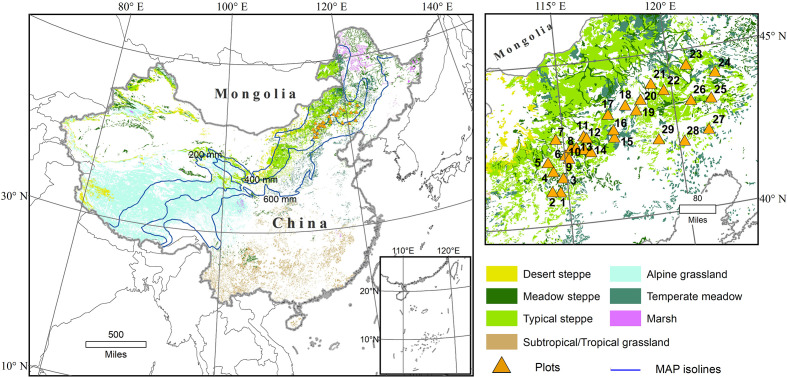
Distribution of grass types in China, with locations of the study region and sampling sites (orange triangles with numbers consistent with
Table 1
; modified from Yang et al., 2019).